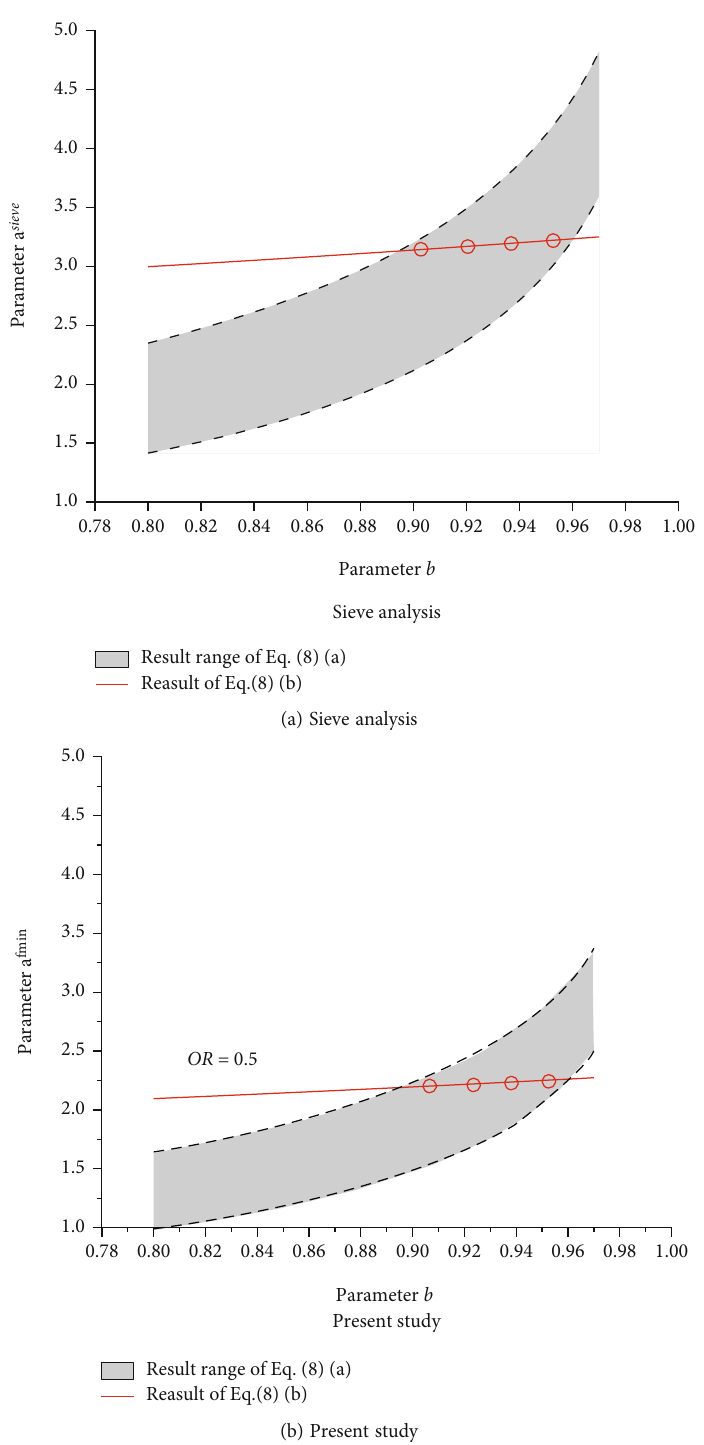
Figure 13: Calculation of a case of a series of